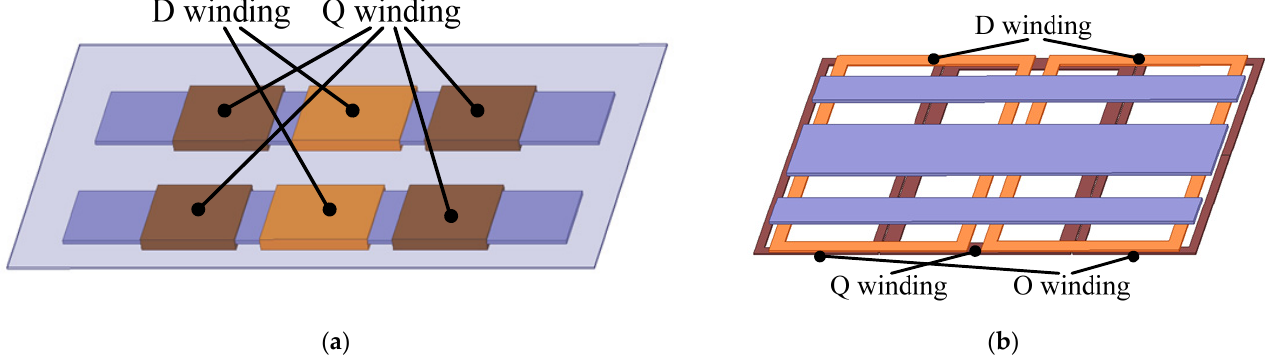
Figure 8. Diagrams of ( a ) the proposed dual-phase NSP receiver and ( b ) the reference dual-phase DD-OQO